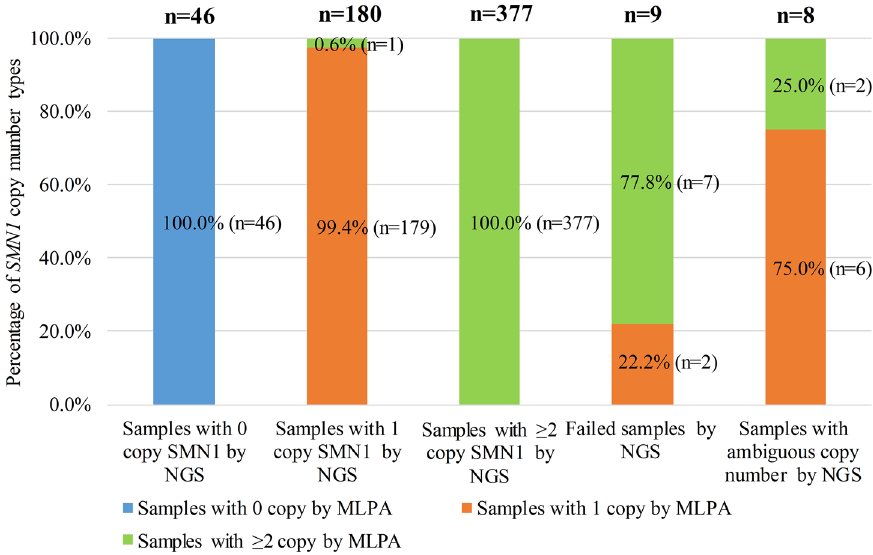
Figure 2. The results of NGS. A total of 620 reactions were implemented for the 478 samples and 142 repetitions of the 71 repeatability study samples with NGS. With NGS method, 8 reactions results were as ambiguous copy numbers, 9 reactions failed, 46 reactions results were 0 copy SMN1 gene, 180 reactions results were 1 copy SMN1 gene, and 377 reactions results were ≥ 2 copies SMN1 gene, each of which is shown as a bar chart. In each bar chart, the samples that were analyzed as 0 copy, 1 copy and ≥ 2 copies of SMN1 gene with MLPA method are shown as the blue, orange and green, respectively.